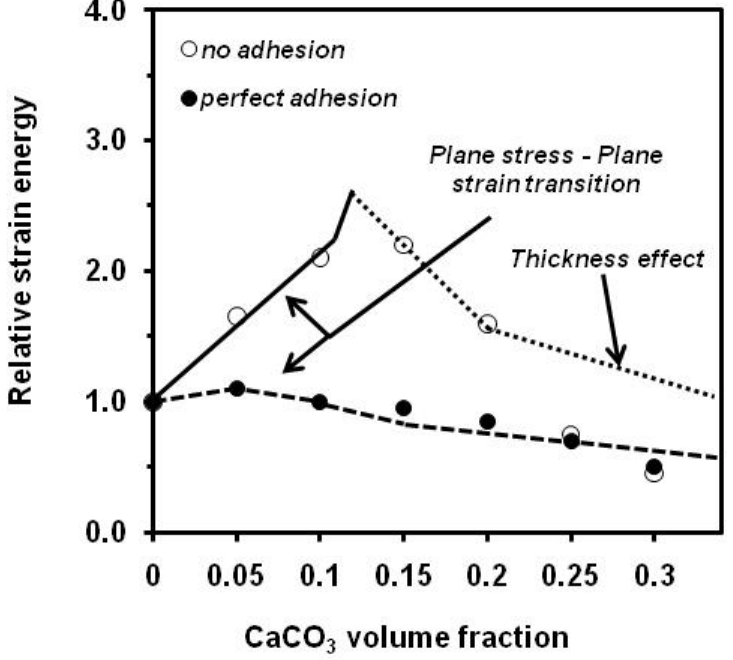
Figure 21. Influence of CaCO energy (adapted from [76]).